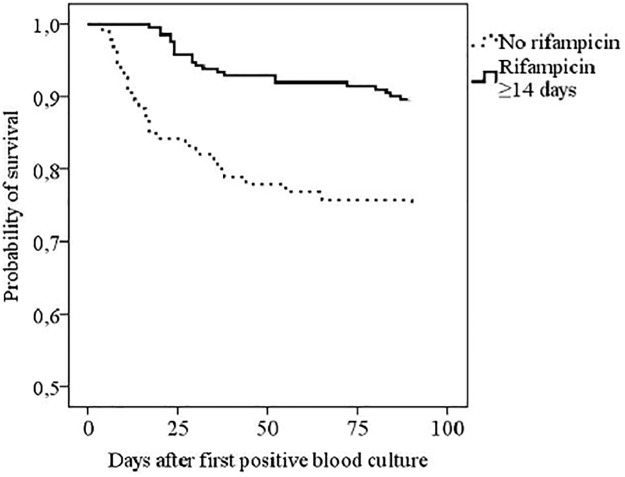
Kaplan-Meier analysis of 90 days survival in 307 Staphylococcus aureus bacteraemia patients with a deep infection focus according to rifampicin therapy (Log-Rank 0.000).The exclusion criteria were: patients with fatal outcome within 3 days of positive blood cultures, patients with alcoholism, acute or chronic liver diseases and patients without a deep infection foci. Patients with methicillin-resistant S. aureus bacteraemia were not included in the study (n = 6).